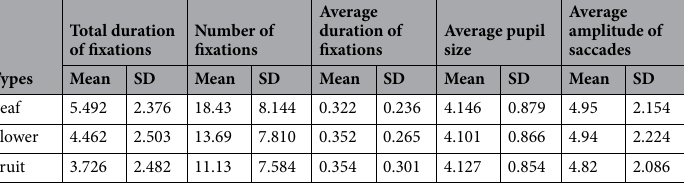
Table 4. Descriptive analysis of eye movement indexes of different organ types. Precision (SD) = standard deviation of data samples.